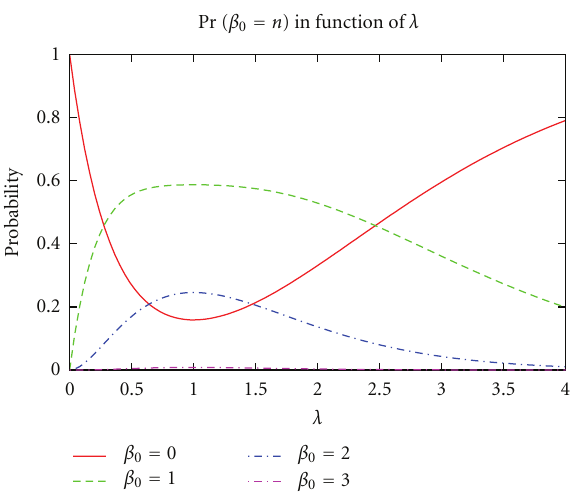
Figure 7: Probabilities of connectiveness, Pr (cid:4) β 0 (cid:4) L (cid:5) (cid:6) n (cid:5) , for n (cid:6) 0 , 1 , 2 , 3, in function of λ when L (cid:6) 4 and (cid:4) (cid:6)